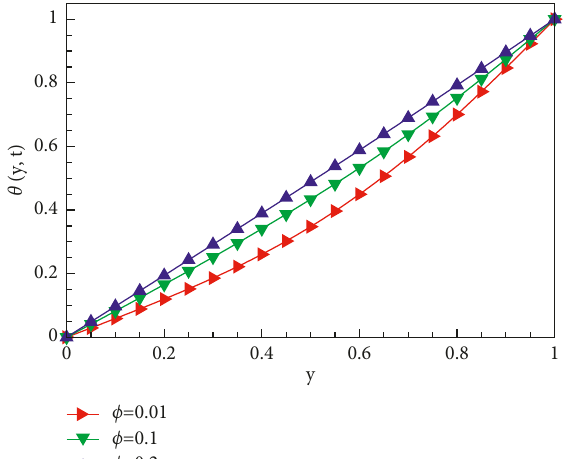
Figure 11: Influence of ϕ on θ when α � β � 1 , λ α